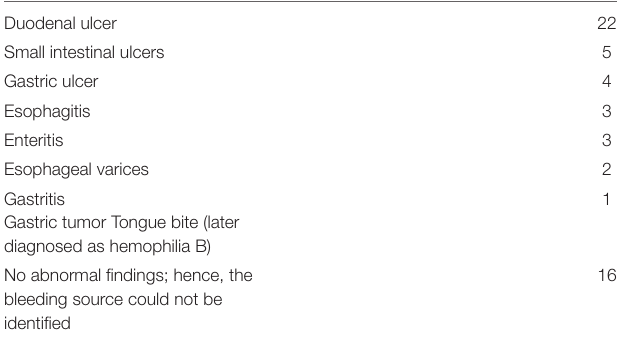
TABLE 2 | Final diagnosis (source of bleeding). TABLE 3 | Predictive factors of a positive diagnosis via EGD in the univariate